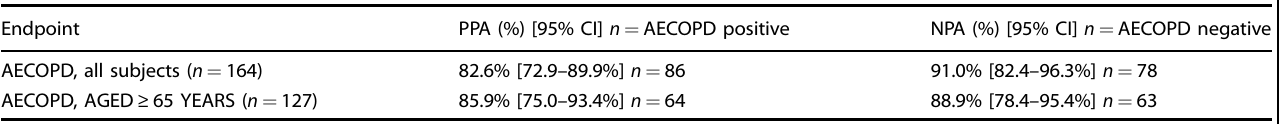
Table 2. Diagnostic agreement for detection of acute exacerbation of chronic obstructive pulmonary disease.